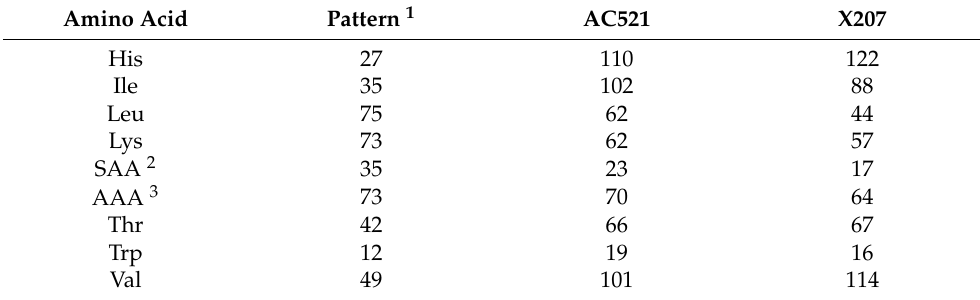
Table 8. Quality assessment of root proteins according to their essential amino acid scoring pattern from ahipa AC521 and interspecific hybrid P. ahipa × P. tuberosus X207. Amino Acid Pattern